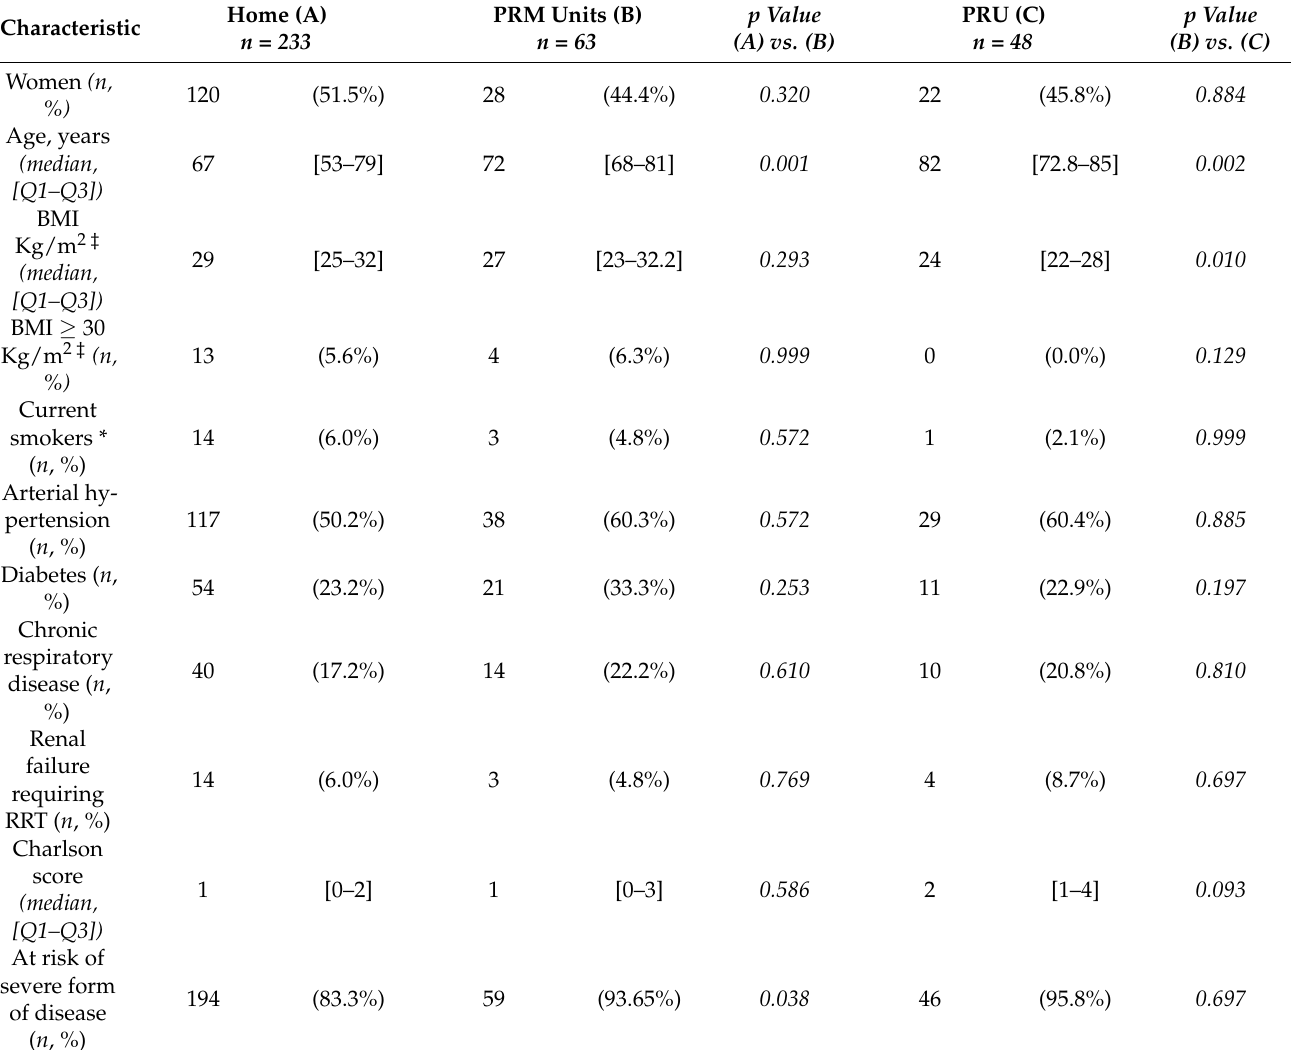
Table 1. Characteristics of patients according to discharge destination (PRM, PRU,